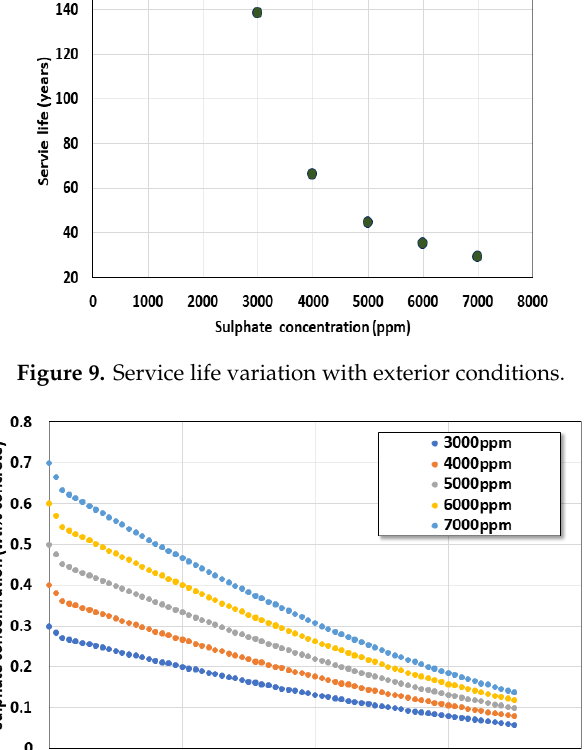
Figure 6. ( a ) Sulfate ion profile with cover depth after 49.1 year; ( b ) increasing sulfate ion at steel location with time.